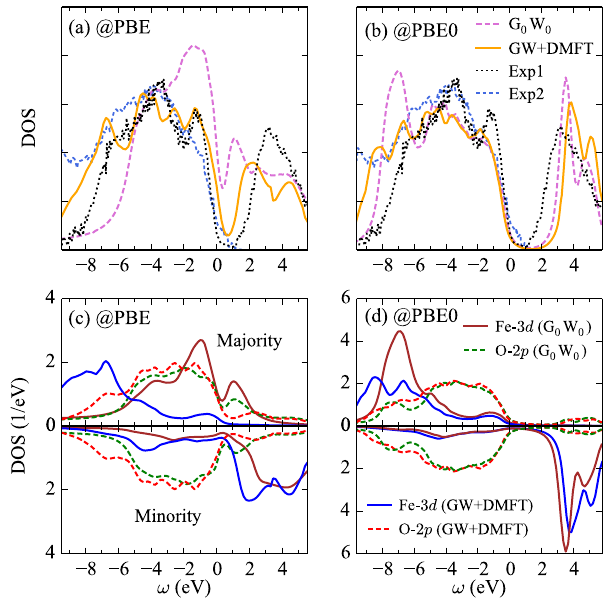
FIG. 4. Spatially resolved DOS from GW þ DMFT (PBE reference) for NiO in the (001) plane. (a) Local DOS at ω ¼ − 2 . 4 eV. (b) Momentum-resolved DOS at VBM energy ω ¼ − 1 . 0 eV and Z ¼ ð 0 . 5 ; 0 . 5 ; 0 . 5 Þ point.